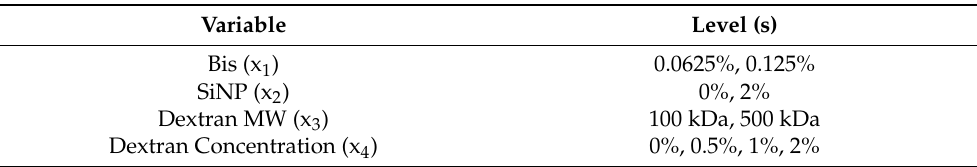
Table 2. Interpenetrating network factor levels for the MANOVA analyses for investigation into the G’, G”, and tan( δ )